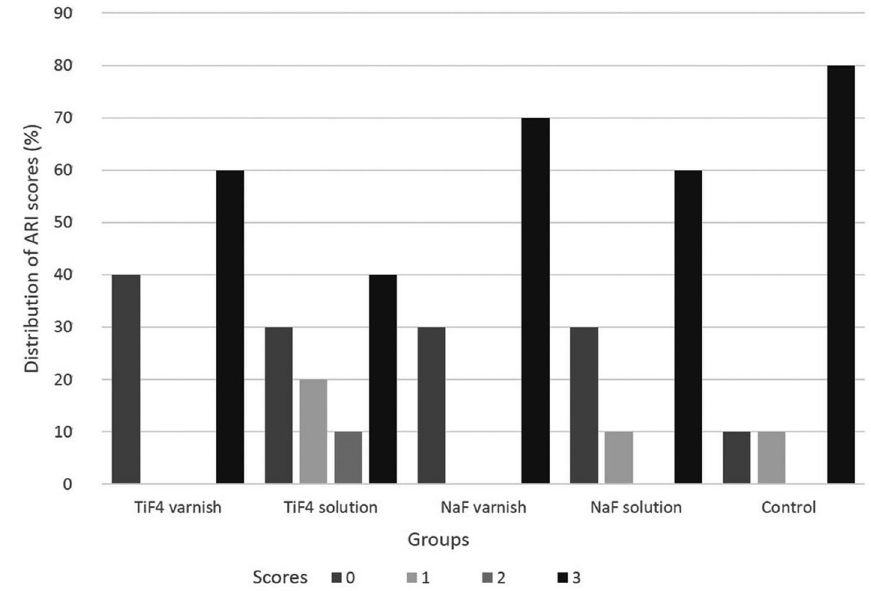
Figure 3- Distribution of Adhesive Remnant Index (ARI) scores (%) for each group